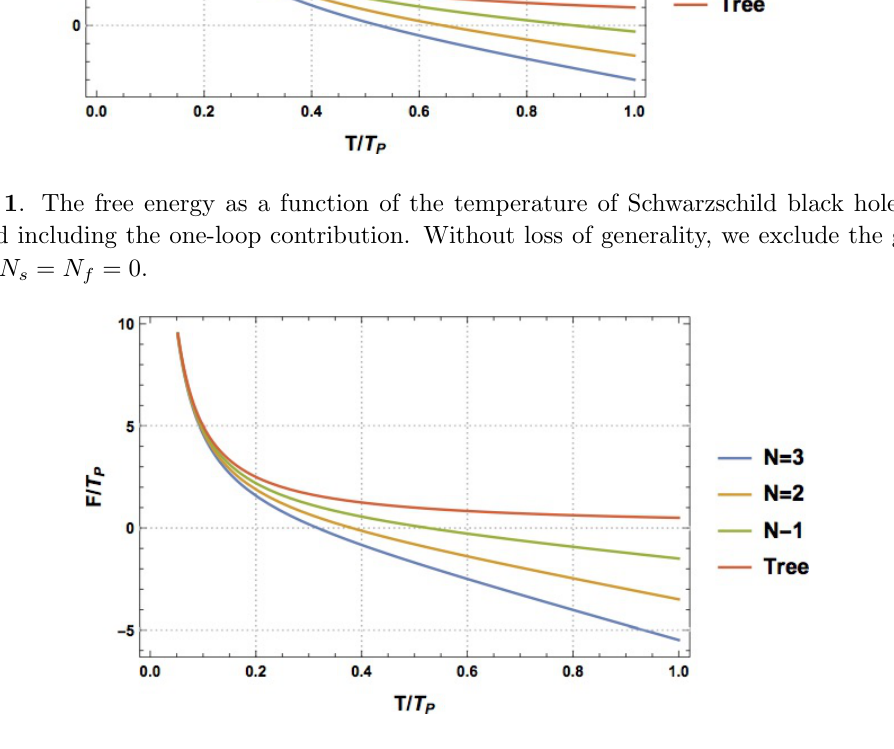
Figure 2 . The free energy as a function of the temperature of Schwarzschild black hole at tree level and including the one-loop contribution. Without loss of generality, we exclude the graviton and set N s = N f = 0. Here, we (cid:12)x T QG =T P = 0 :